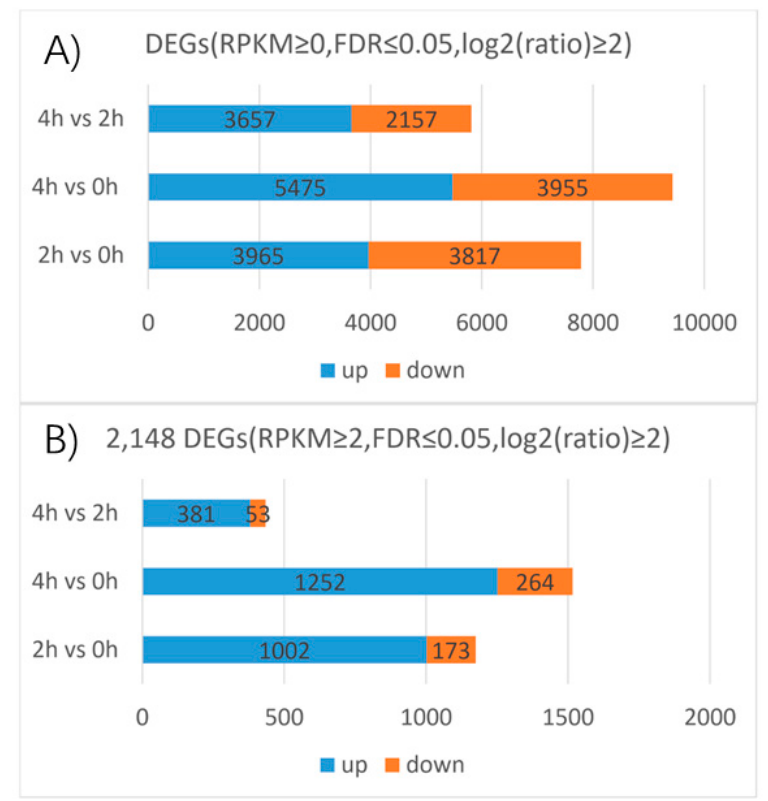
Figure 6. Upanddowndifferentialexpressionofgenes. ( A )DEGswerefilteredwithanRPKM ≥ 0,FDR ≤ 0.05 and | log 2 (ratio) | ≥ 2. ( B ) DEGs were filtered with an RPKM ≥ 2, FDR ≤ 0.05 and | log 2 (ratio) | ≥ 2.C). Figure 6. Up and down differential expression of genes. ( A ) DEGs were filtered with an RPKM ≥ 0, FDR ≤ 0.05 and Filtering with anRPKM ≥ 2, FDR ≤ 0.05 and | log2(ratio) | ≥ 2, 2148 genes were di ff |log 2 (ratio)| ≥ 2. ( B ) DEGs were filtered with an RPKM ≥ 2, FDR ≤ 0.05 and |log 2 (ratio)| ≥ 2.C).